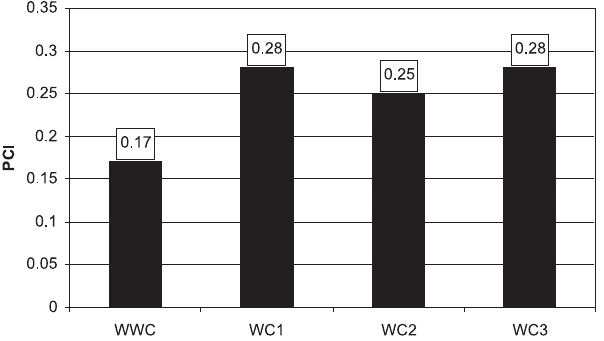
Figure 1 - Mean energy expenditure (Physiological cost index – PCI) in patients with knee OA while walking without a cane (WWC), walking with a cane length to the greater trochanter length (WC1), walking with a cane length to the distal wrist crease (WC2) and walking with a cane length ob- tained by the formula: individual height x 0.45 + 0.87 m